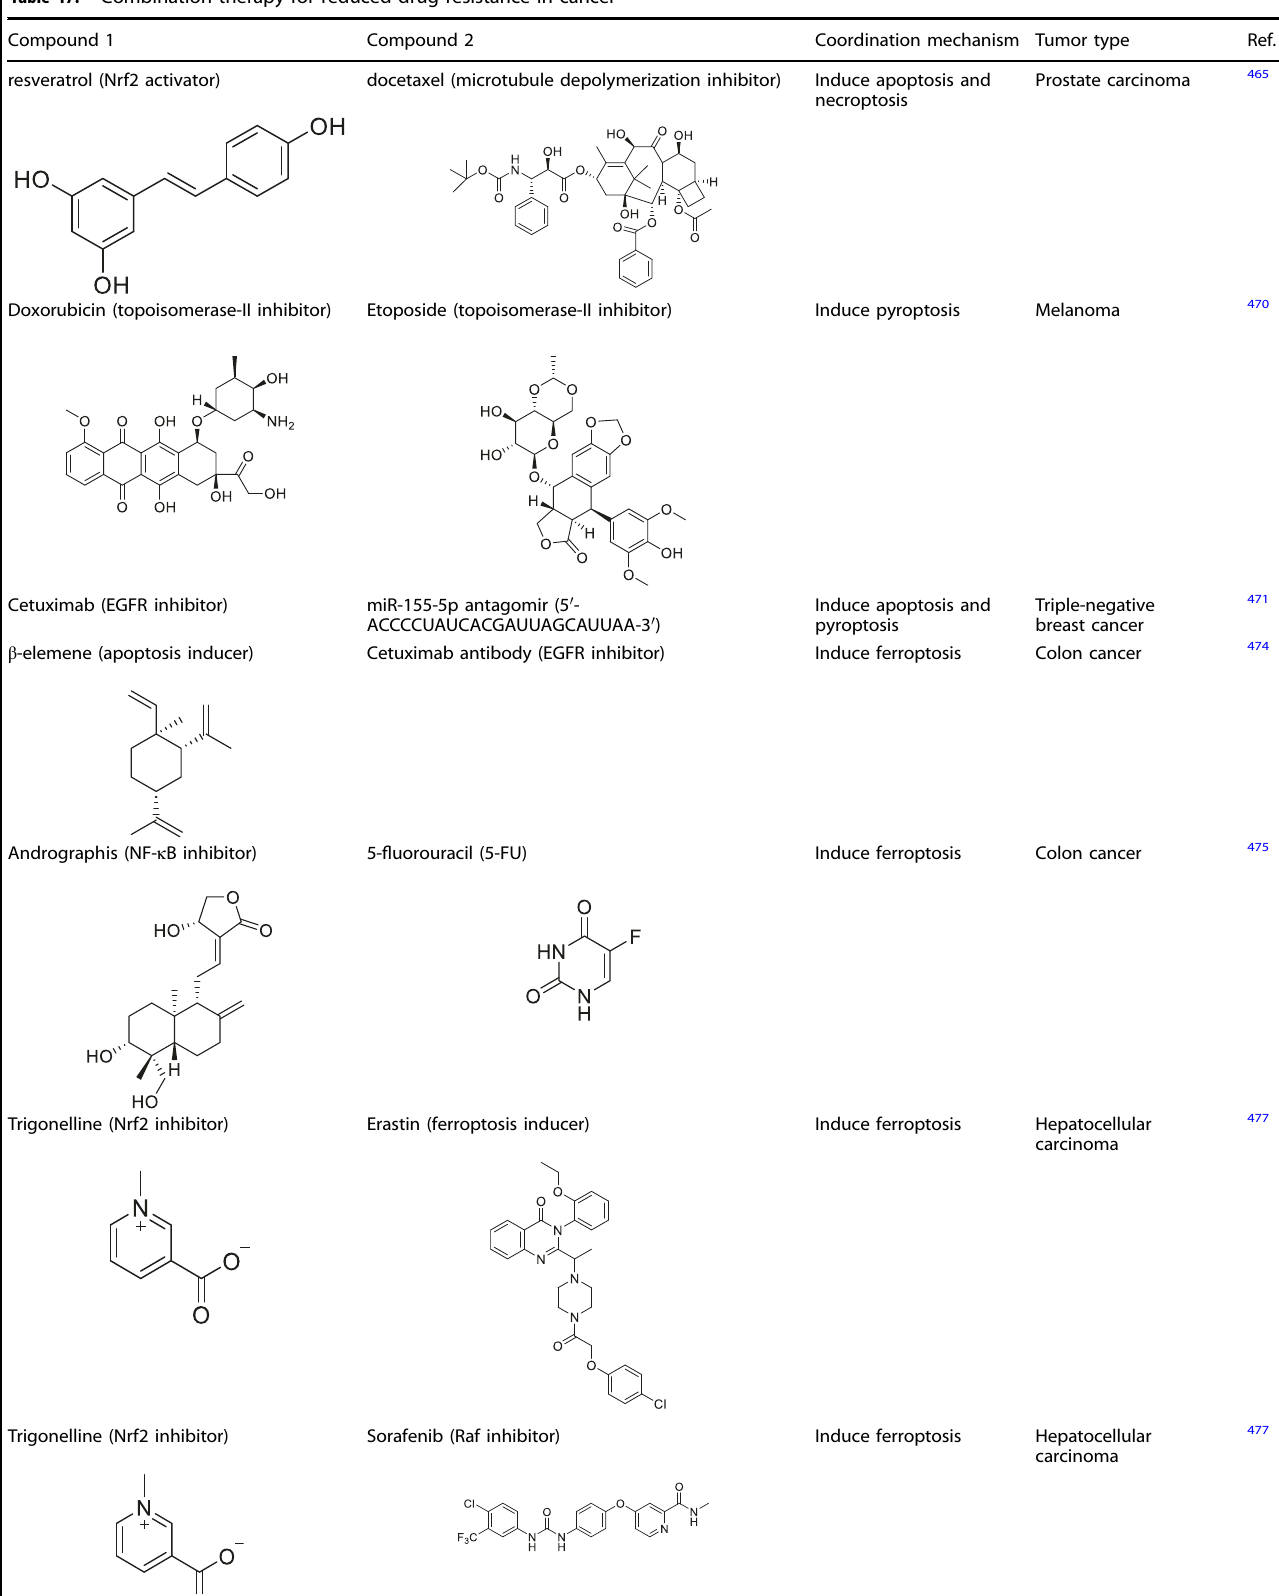
Table 17. Combination therapy for reduced drug resistance in